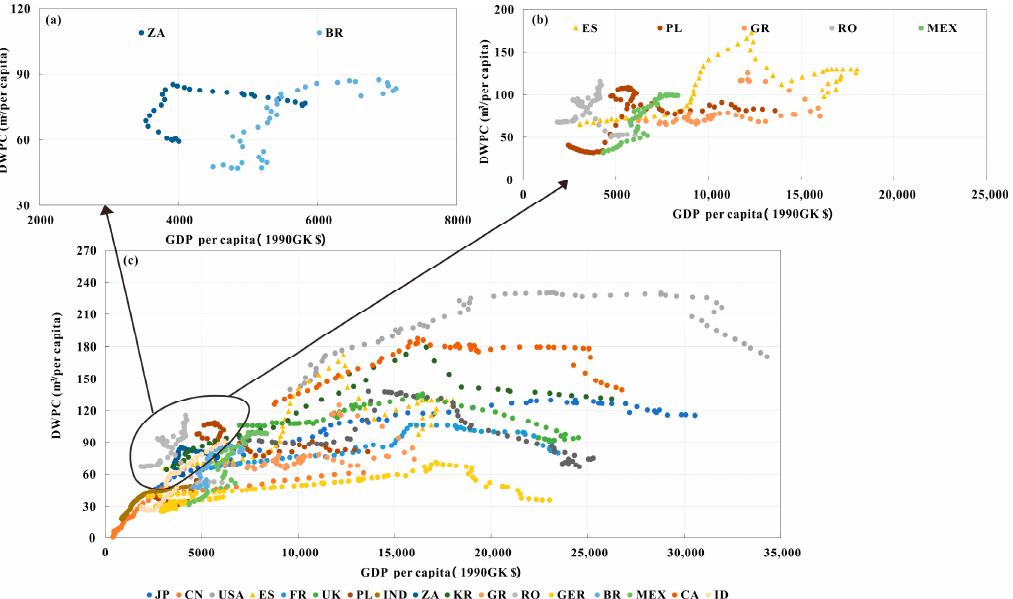
Figure 1. Relationship between GDP per capita and DWPC for ( a ) South Africa and Brazil; ( b ) Spain, Poland, Greece, Romania, and Mexico; and ( c ) all 17 countries.